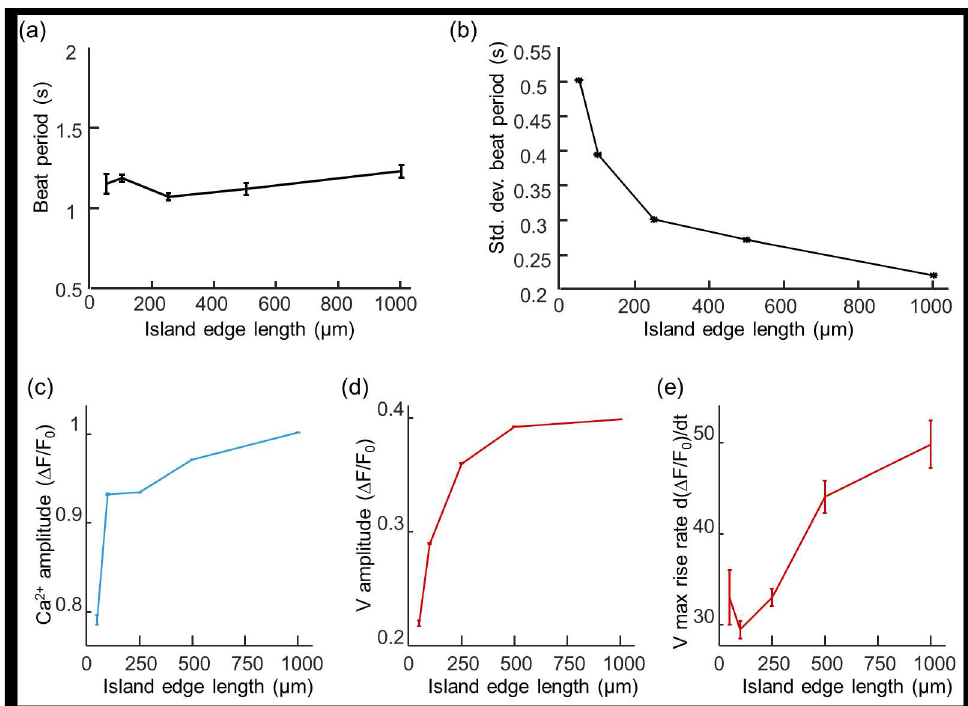
Fig 3. Island size-dependent action potential parameters in hiPSC-CM. a) Mean spontaneous beat period as a function of island size at 14 dpp. b) Standard deviation of beat period across islands, as a function of island size. c) Amplitude of the calcium transient as a function of island size. d) Amplitude of the voltage transient as a function of island size. e) Rise time (20% to 80%) of the voltage transient as a function of island size. Error bars in a,c-e represent